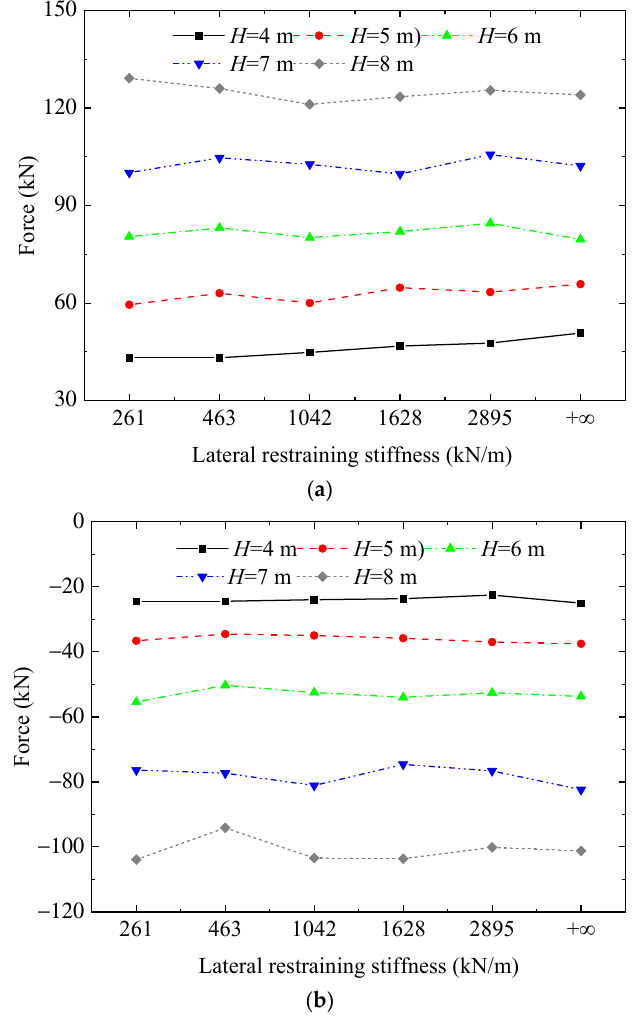
Figure 14. Influence of the lateral restraining stiffnesses on the horizontal force for Case E20/Cs (0). ( a ) Positive force; ( b ) Negative force. When the submersion coefficient Cs = 0, the influence of different lateral restraining stiffnesses on the vertical peak force on the box-girder superstructure is shown in Figure 15. Compared with the fixed box-girder superstructure, it is noteworthy that with the lateral restraining stiffness of the box-girder superstructure decreasing (i.e., with the